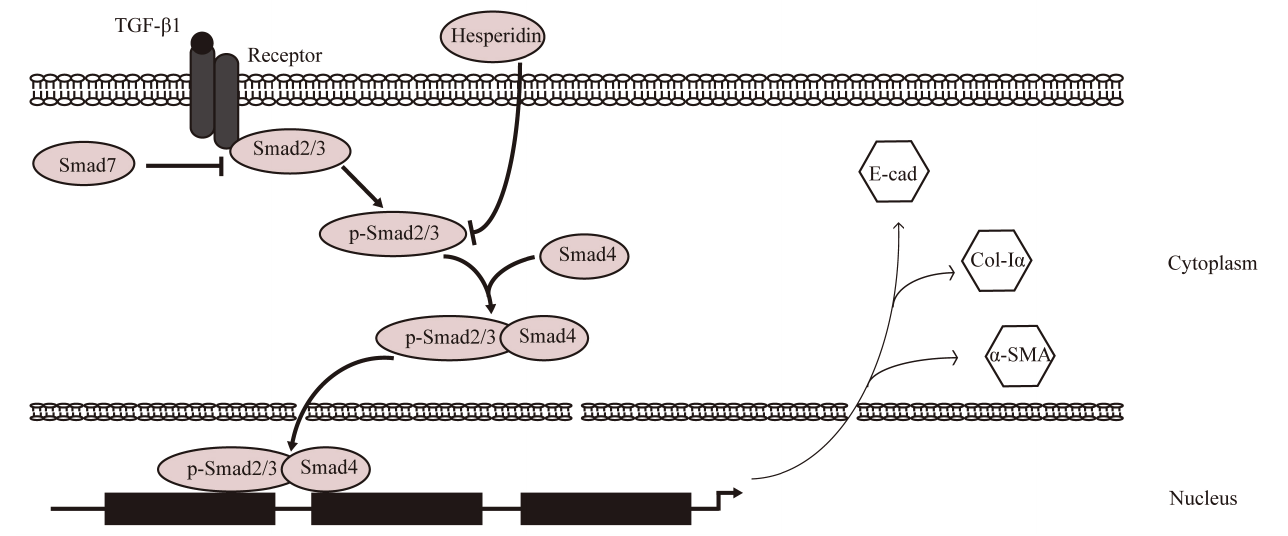
FIGURE 5 - Cartoon of the inhibitory effect of hesperidin on TGF-β1-induced EMT through the Smad pathway in the